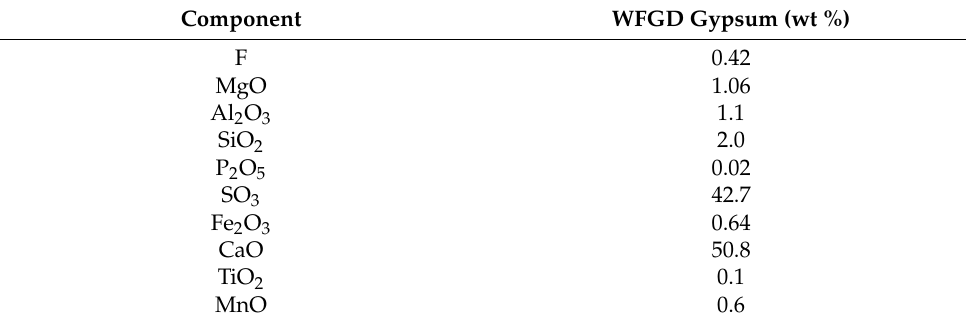
Table 1. Elemental composition of WFGD